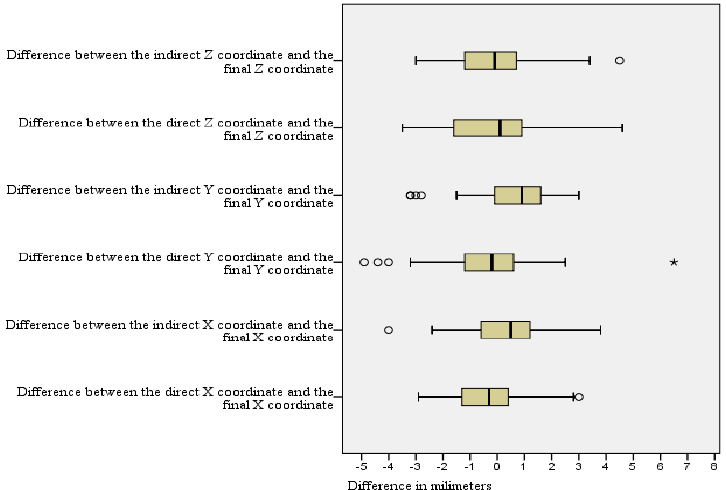
Figure 13. The differences between the direct and indirect coordinates of the subthalamic nucleus from the final active electrode coordinates. ◦ : outliers.